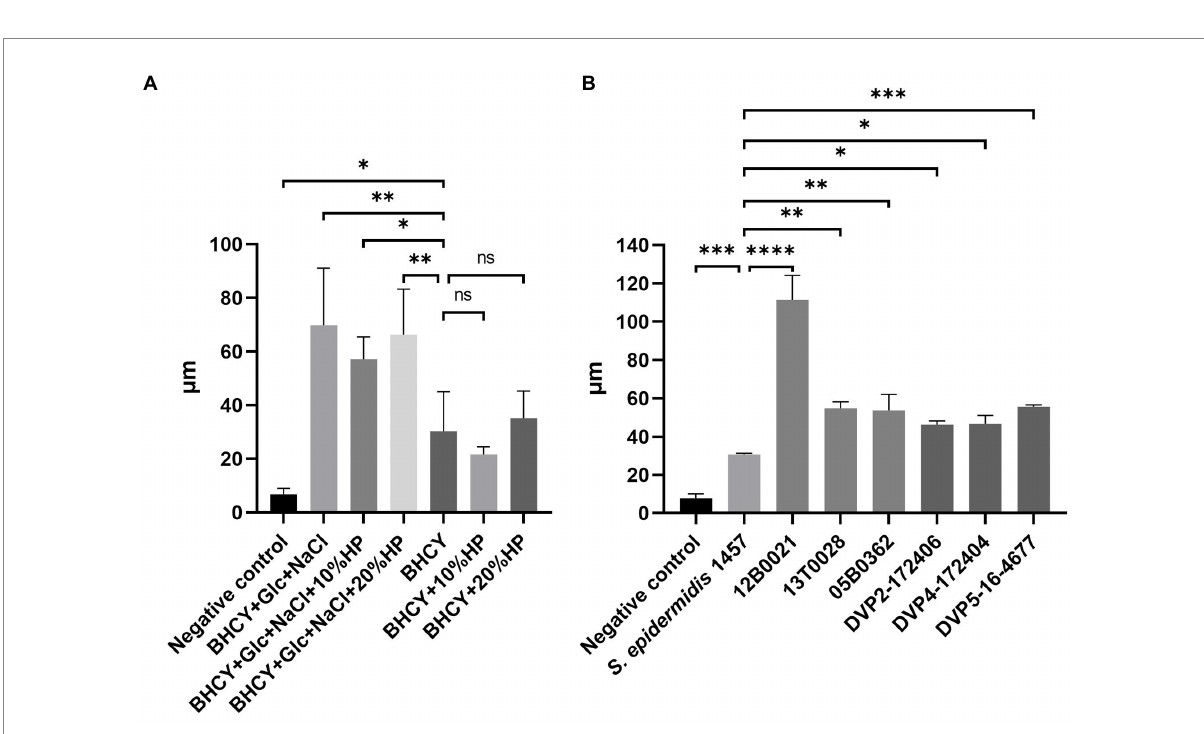
FIGURE 2 Biofilm formation of S. saccharolyticus quantified by OCT. (A) Biofilm formation of S. saccharolyticus strain 13 T00328 in culture media containing different supplements. Biofilm thickness was highest in BHCY broth supplemented with 1% glucose (Glc) and 1% NaCl. The media supplementation with human plasma (HP) did not lead to an additional increase in biofilm thickness. (B) Biofilm formation of different strains of S. saccharolyticus . As growth medium, BHCY supplemented with 1% glucose and 1% NaCl was used. S. epidermidis 1457 was used as positive control, and medium without bacteria as negative control. Three biological replicates were performed. ∗ , p < 0.05; ∗ ∗ , p < 0.01; ∗ ∗ ∗ , p < 0.001; ∗ ∗ ∗ ∗ , p < 0.0001; ns, not significant; determined by comparison to negative control (Welch’s t